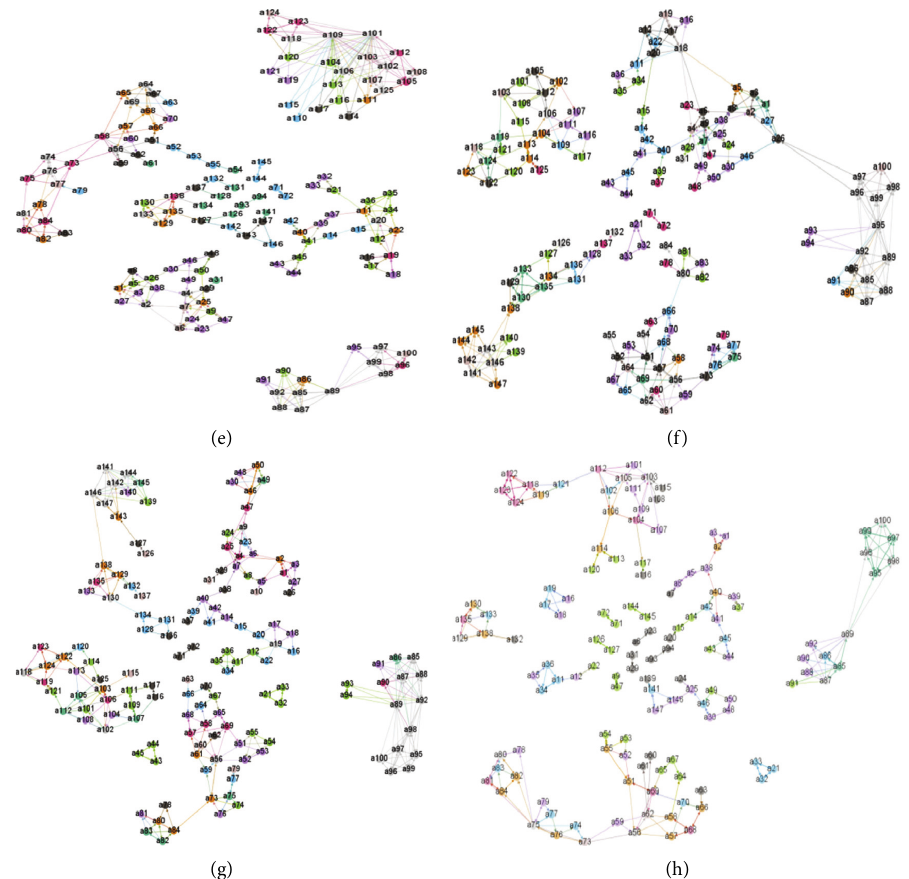
Figure 2: Topology of the online social network. (a) Practical online support network. (b) Emotional online support network. (c) Social online support network. (d) Employment online discussion network. (e) Achievement online support network. (f) Revenue online discussion network. (g) Professional online discussion network. (h) Love and marriage online discussion